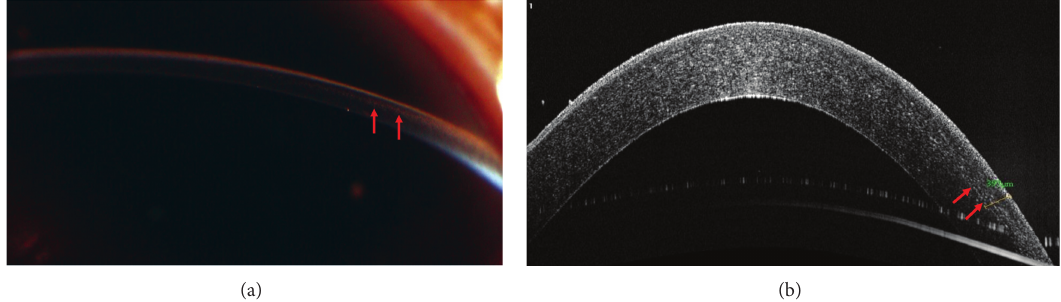
Figure 4: (a) Midstromal Opacity as seen by slit lamp. (b) Midstromal Opacity measured to a depth of 397 𝜇 m. The arrow indicates the location of